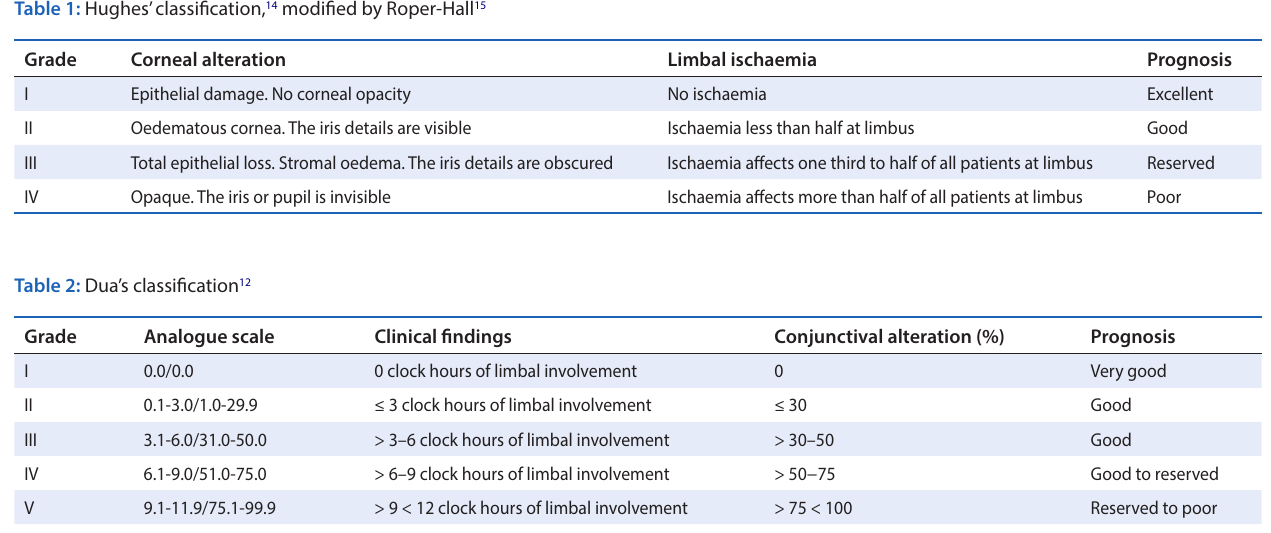
Table 1: Hughes’ classification, 14 modified by Roper-Hall 15